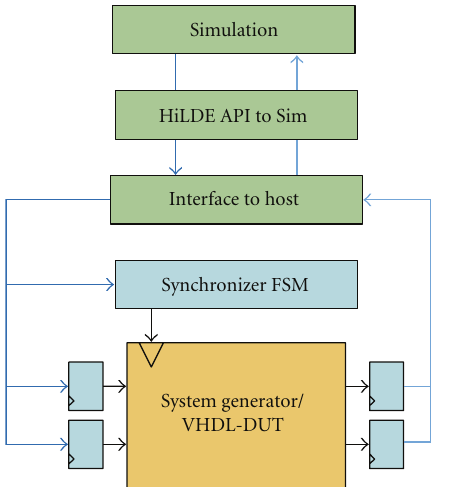
Figure 2: HiLDE hardware wrapper controlling the DUT-IOs and clock.